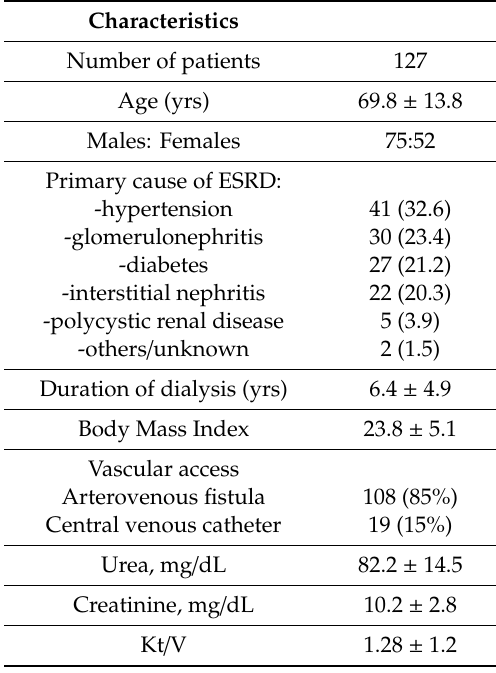
Table 1. Characteristics of 127 patients included in the